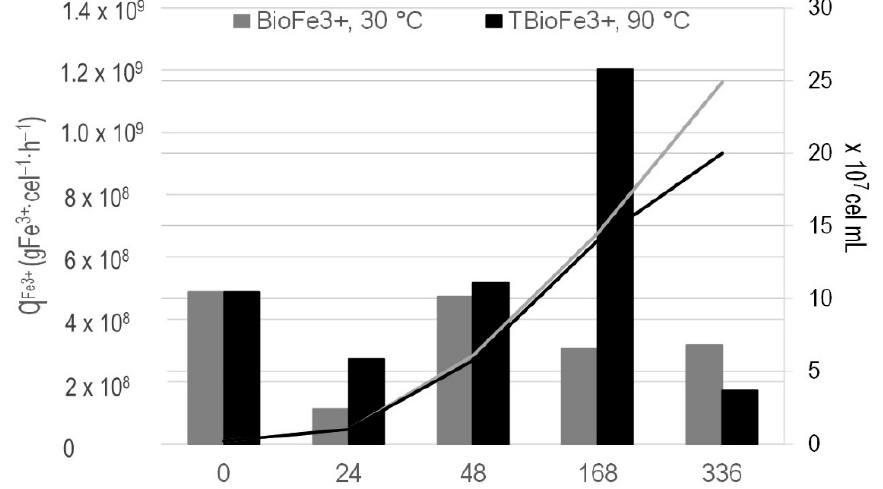
Figure 5. Accumulated specific productivity of Fe 3+ ions ( q(cid:3364) (cid:2890)(cid:2915) (cid:3119)(cid:3126) ) and biomass density after 336 h of bio-oxidation using the T6 community and the FeS 2 concentrate previously preoxidized with BioFe 3+ at 30 or 90 °C.